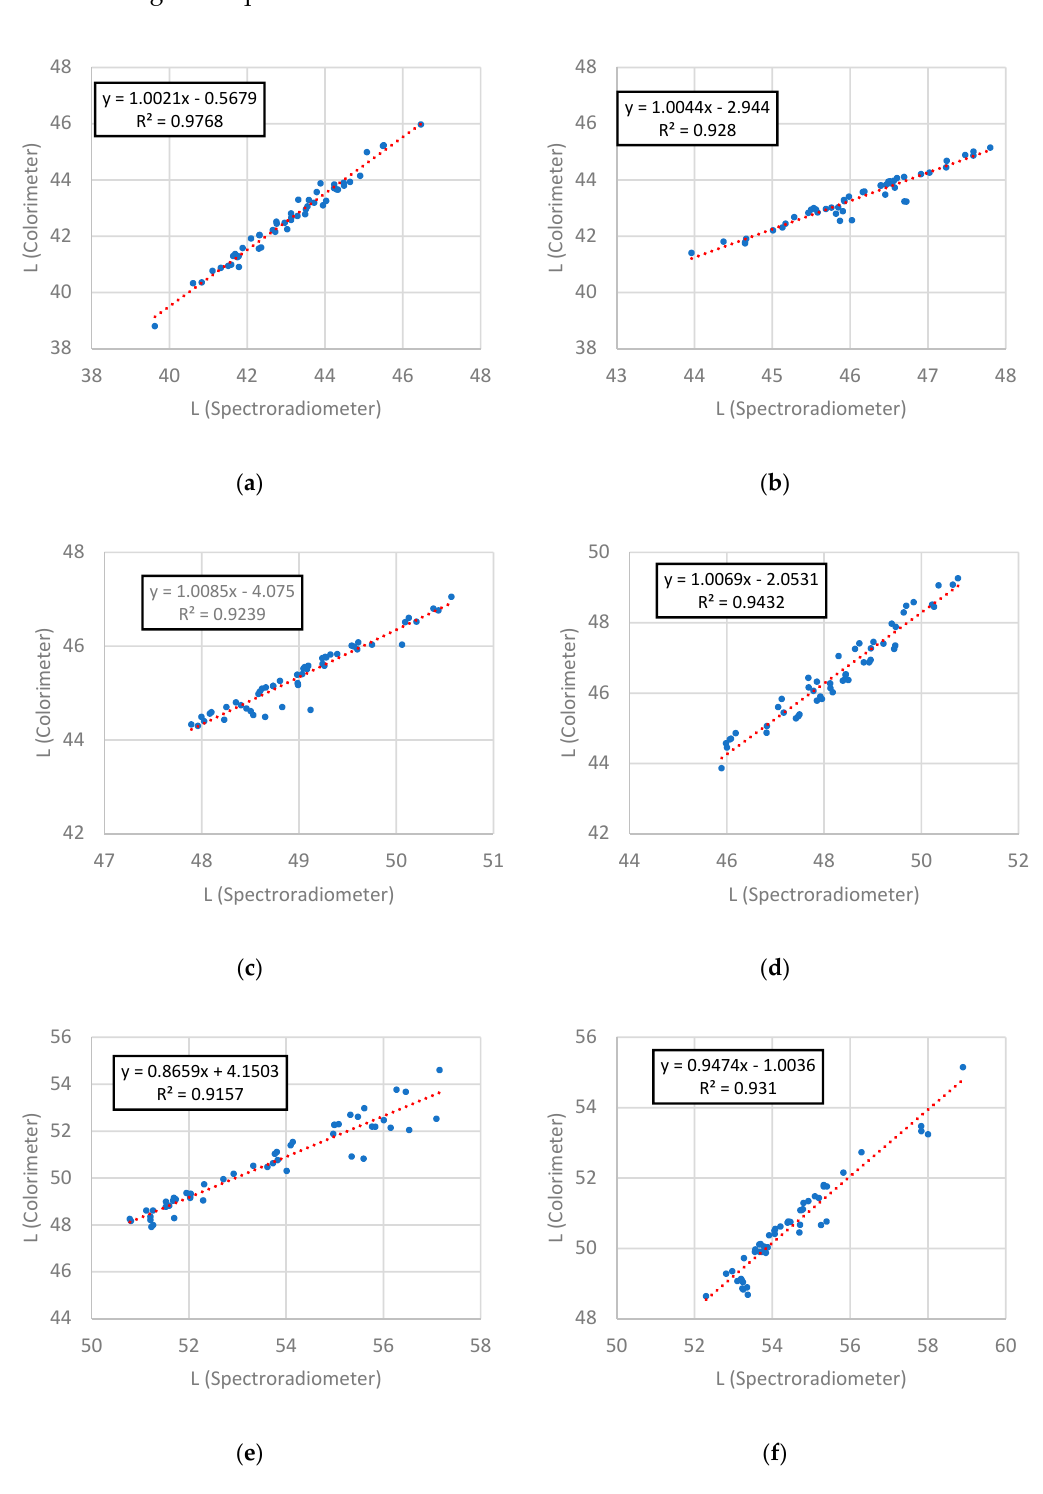
Figure 6. Correlation plots for each study area between colorimeter and spectroradiometer data for Study Area A1 ( a ), Study Area A2 ( b ), Study Area B1 ( c ), Study Area B2 ( d ), Study Area C1 ( e ), Study Area C2 ( f ).